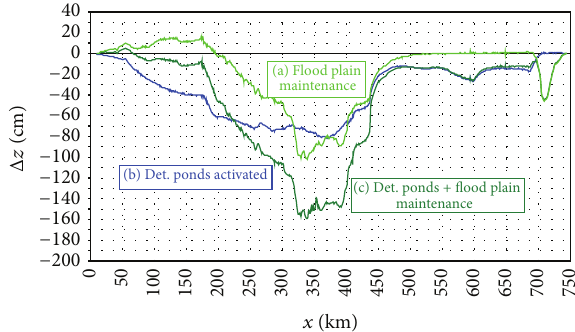
Figure 5: Calculated effects of flood plain maintenance and activa- tion of detention ponds on the peak water levels in case of the 2000